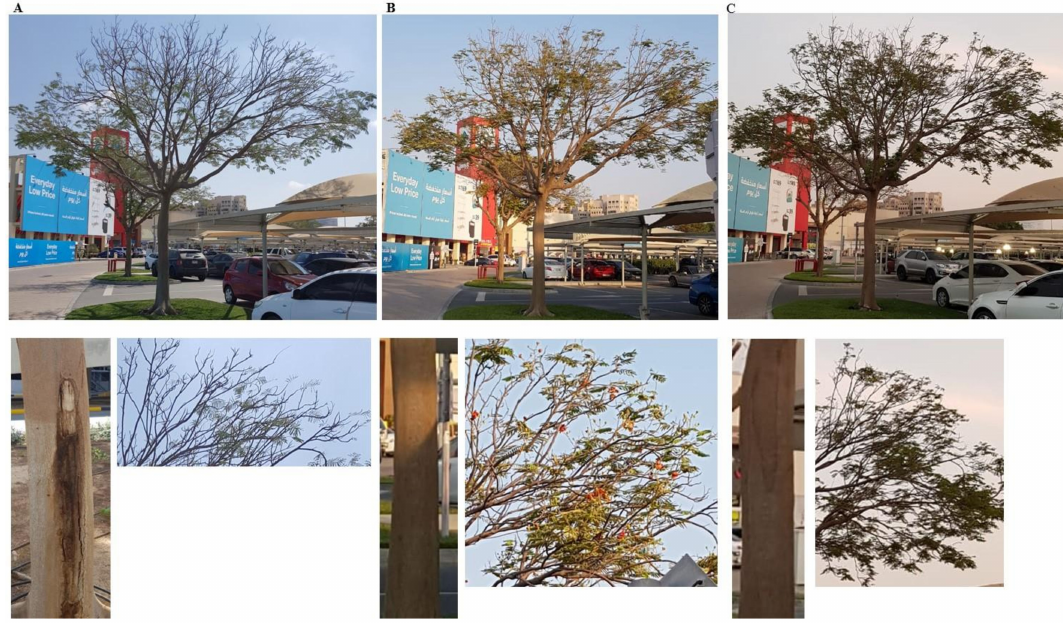
Figure 8. E ff ect of Cidely ® Top on royal poinciana trees naturally infected with N. dimidiatum in the field in DFC, UAE. Fungicidal suppression of stem canker disease symptoms on ( A ) royal poinciana trees ( n = 6); followed by treatment with the fungicide Cidely ® Top at ( A ) 0 ( B ) 16 and ( C ) 32 weeks post treatment. In ( A–C ), photos showed the severe disease symptoms and the recovery of the same whole tree (upper panel), trunk (left, bottom panel) and branches (right, bottom